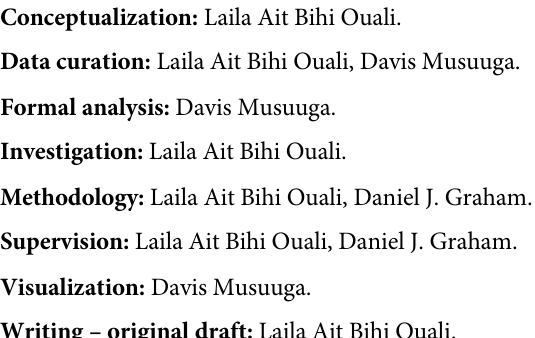
S1 Table. Road share in London—Source: DfT AADF data. S2 Table. Difference-in-mean estimates for the introduction of the WEZ. S3 Table. Difference-in-mean estimates for the removal of the WEZ. S4 Table. DiD estimates from analysis of the introduction of the WEZ. S5 Table. DiD estimates from analysis of the introduction of the WEZ using CDRC data. S6 Table. DiD estimates from analysis of the removal of the WEZ using CDRC data. S7 Table. Results from the placebo test for introduction of the